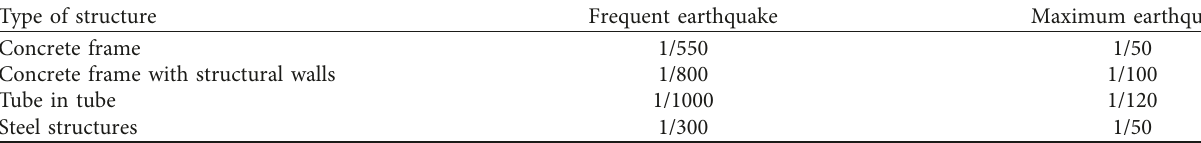
Table 12: Drift limits in the superstructure in the Chinese code [20].